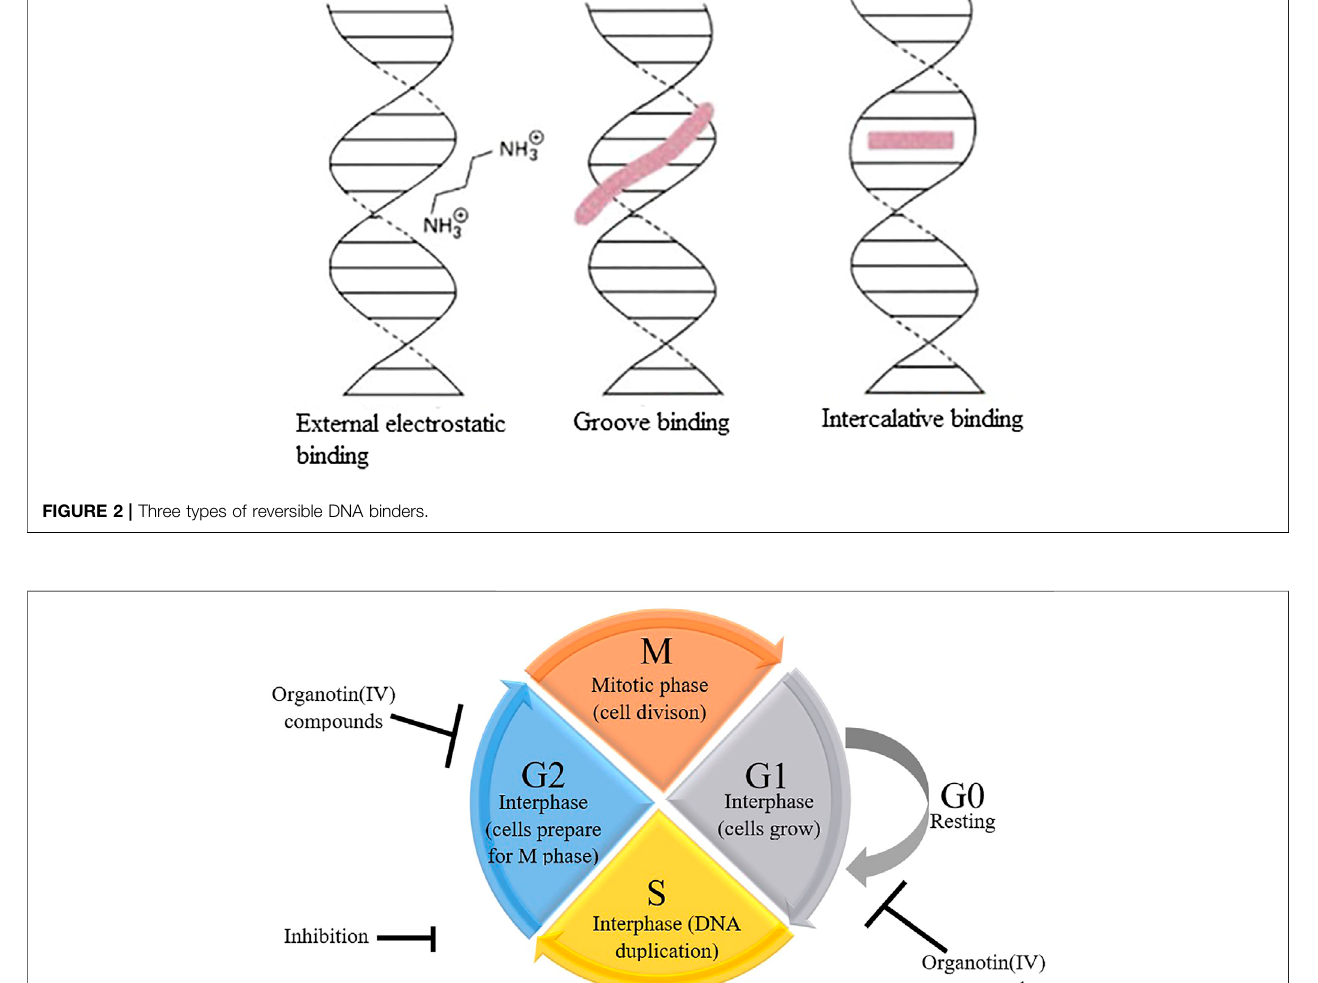
Frontiers in Chemistry |